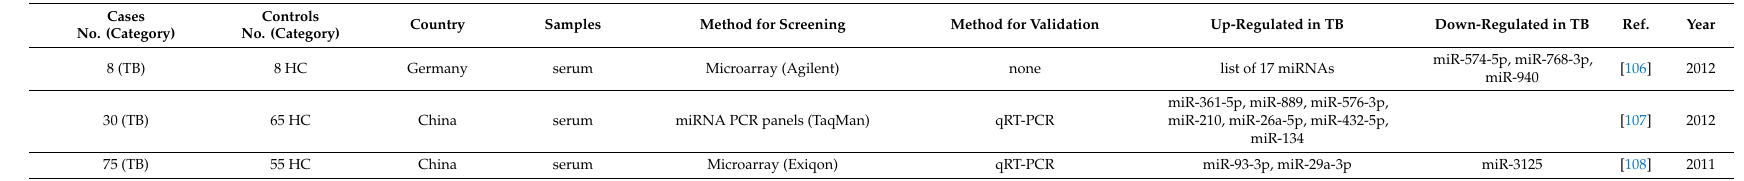
Table 3. Summary of miRNA biomarker discovery studies in blood cells (in vivo or ex vivo) from TB subjects and controls. Subjects No.